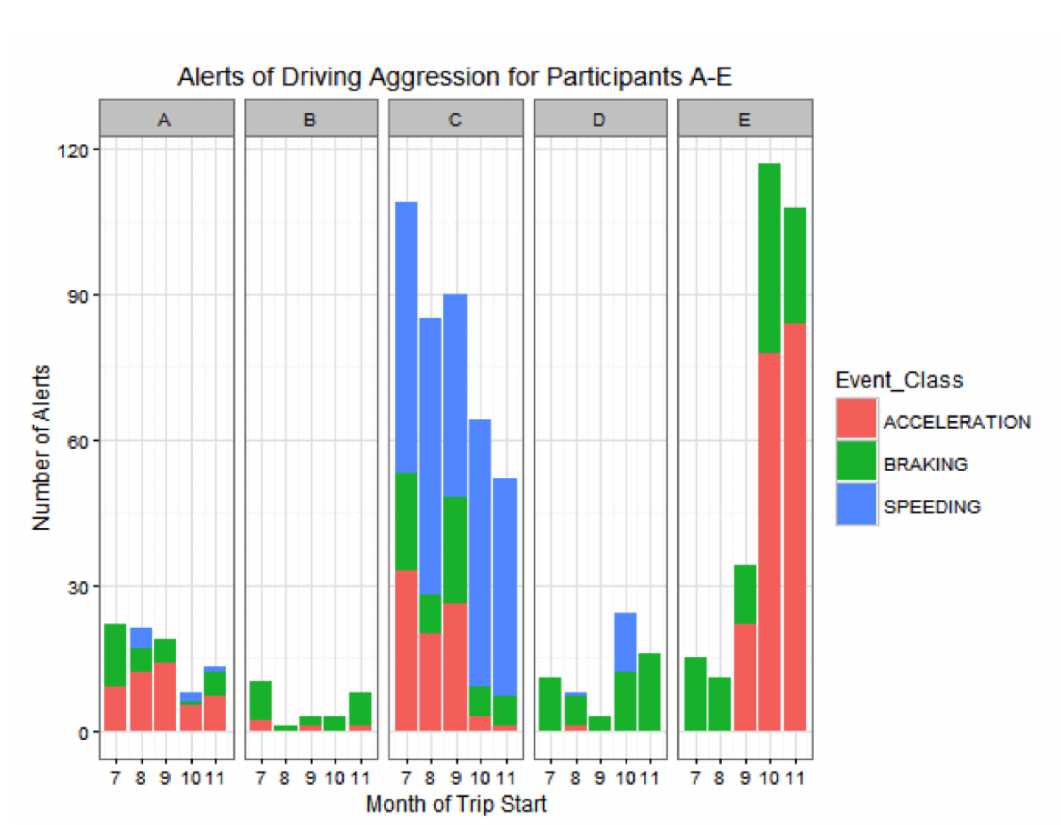
Figure 10. Total number of alerts across the 5